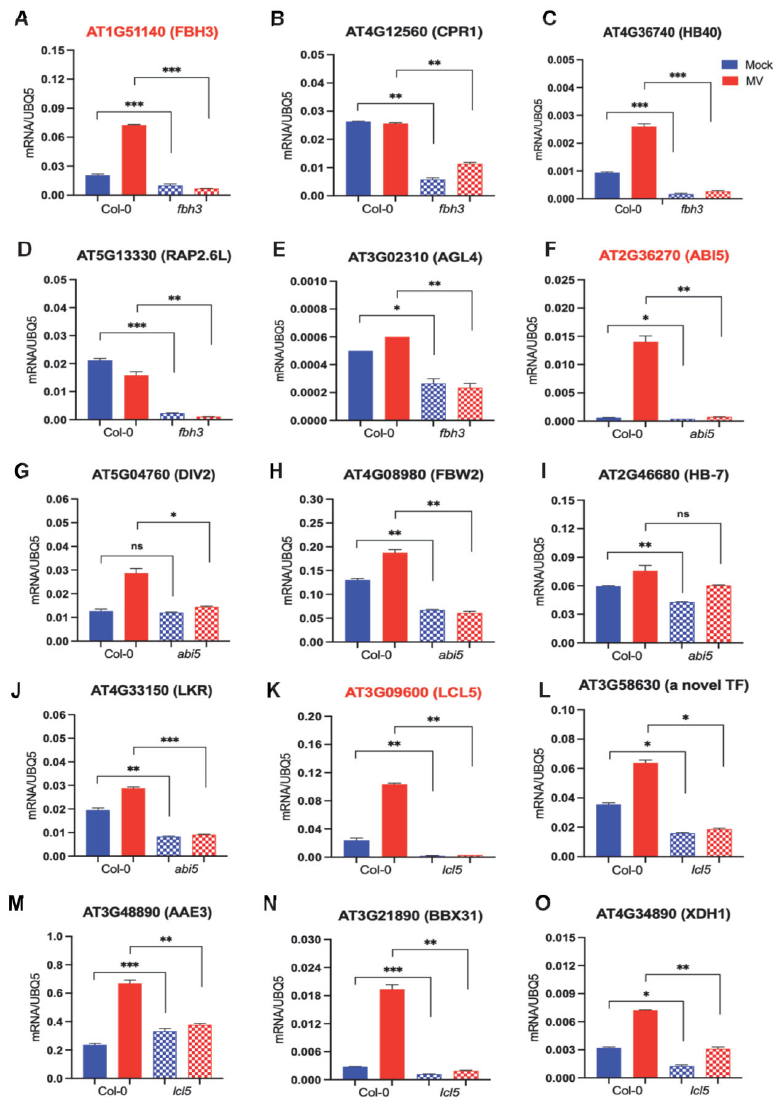
Figure 6. Gene expression profile of transcription factors (red) and their targets in Col-0, fbh3 mutant, abi5 mutant, and lcl5 mutants in 1/2 MS media and 2uM methyl viologen (MV) treatment conditions. RT-qPCR was performed in leaf samples collected after 7 days of treatment. Gene expression was assessed using reference gene UBQ5 in three groups: TF1 ( A ) AT1G51140 and targets ( B ) AT4G12560, ( C ) AT4G36740, ( D ) AT5G13330, ( E ) AT3G02310; TF2 ( F ) AT2G36270 and targets ( G ) AT5G04760, ( H ) AT4G08980, ( I ) AT2G46680, ( J ) AT4G33150; TF3 ( K ) AT3G09600 and targets ( L ) AT3G58630, ( M ) AT3G48990, ( N ) AT3G21890, ( O ) AT4G34890. The graphs represent the mean with standard errors of three technical replicates. Experiments were performed in three biological replications. The statistical significance of the data is denoted by asterisks in the following manner: “* p < 0.05”, by Student’s t -test. The lattice column indicates the significant differences between Col-0 and the mutants in